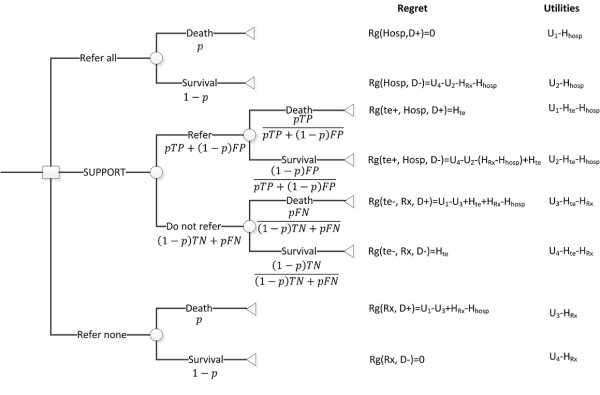
Decision tree describing the overall hospice referral process. In this figure p = P (D +): probability the patient's LE is less than or equal to 6 months; 1 - p = P (D -): probability the patient's LE is greater than 6 months; Ui, i ∈ [1,4]: the utilities corresponding to each of the decision model outcomes; Hosp: hospice referral; Rx treatment continuation; Rg: regret associated with an action; HRx : utility losses due to harms of treatment; HHosp: utility losses due to harms of hospice; Hte: utility losses due to harms of the prognostic test (SUPPORT).